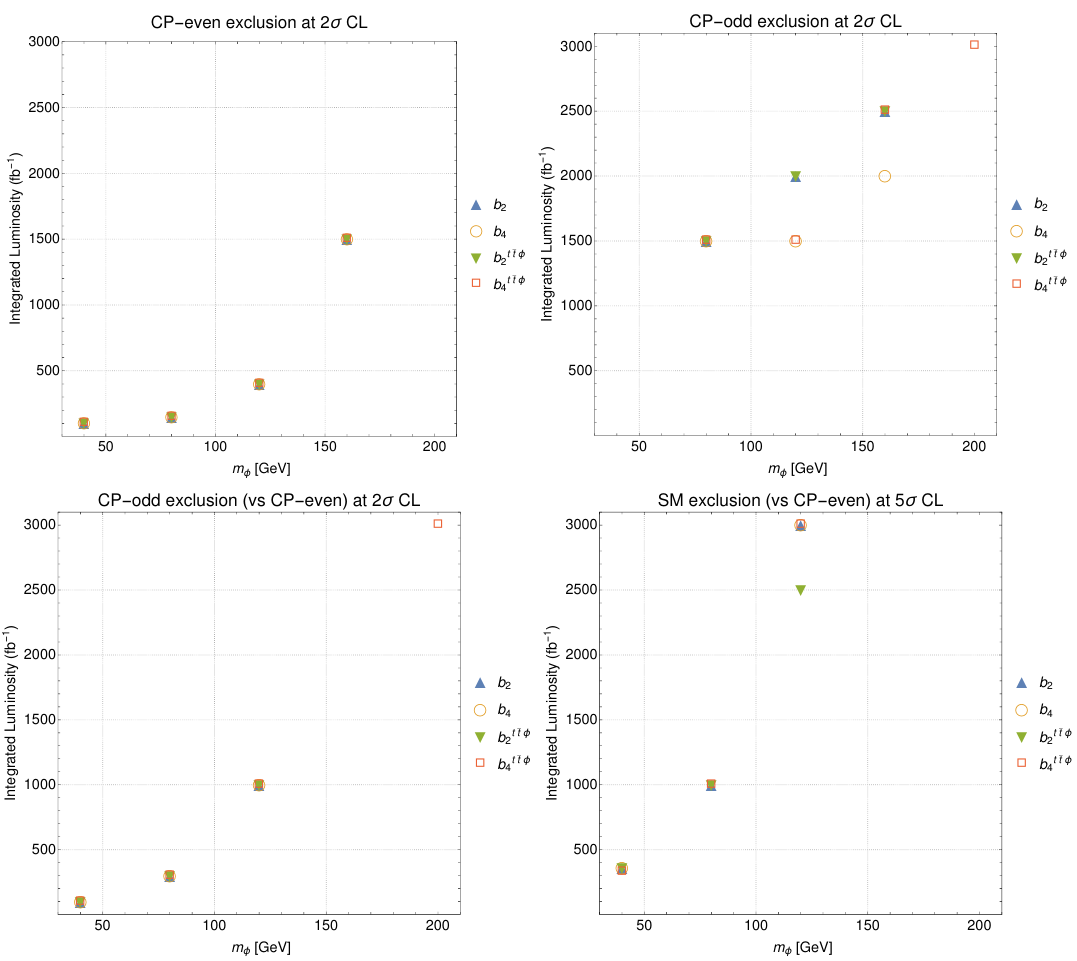
Figure 14. Luminosity needed to exclude scenarios 1 (top left), 2 (top right) and 3 (bottom left) at the 2 (cid:27) level, and scenario 4 (bottom right) at the 5 (cid:27) level, as a function of the (cid:30) boson mass. The top left of (cid:12)gure 14 (Scenario 1) tells us that, with the current LHC luminosity, we can exclude a CP-even scalar boson with CLs that exceed 2 (cid:27) if its mass is m For masses around the SM Higgs boson mass we require roughly 300 fb (cid:0) 1 to achieve the 2 (cid:27) CLs exclusion. This will be obtained during the incoming RUN’s of the LHC. Masses of the CP-even scalar boson above 200 GeV cannot be excluded even at the end of HL-LHC, with the dileptonic channel